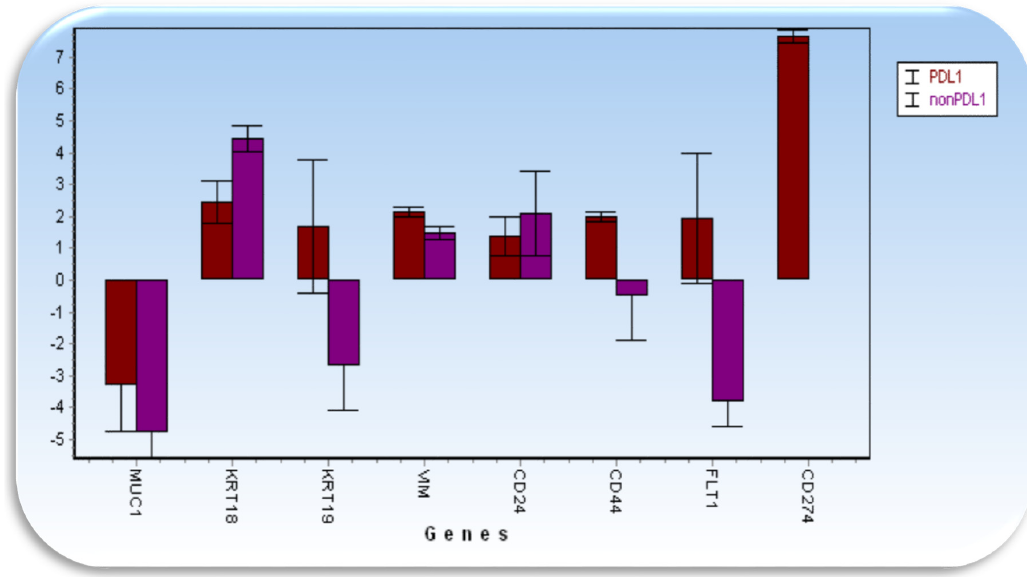
Figure 7. Gene expression analysis of CTC showing differences between the CTC PDL1+ (brown) and CTC PDL1- (violet). The arrows indicate genes expressed differentially between tested groups.